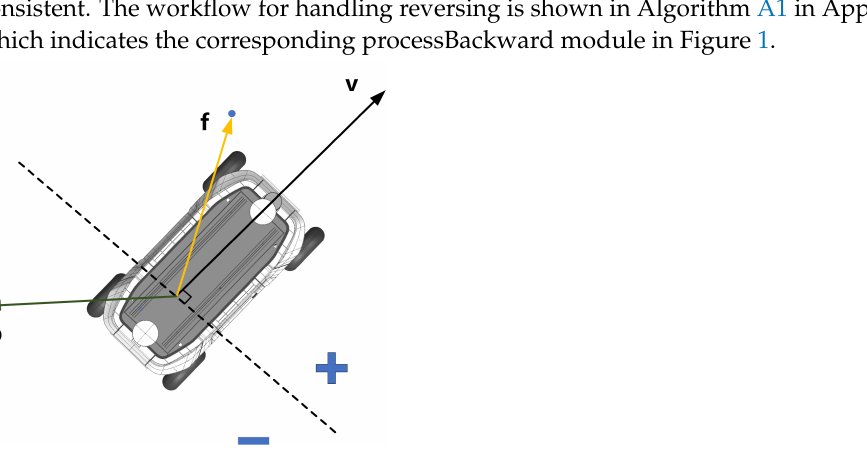
Figure 5. Relationship between the location of given points and the robot.